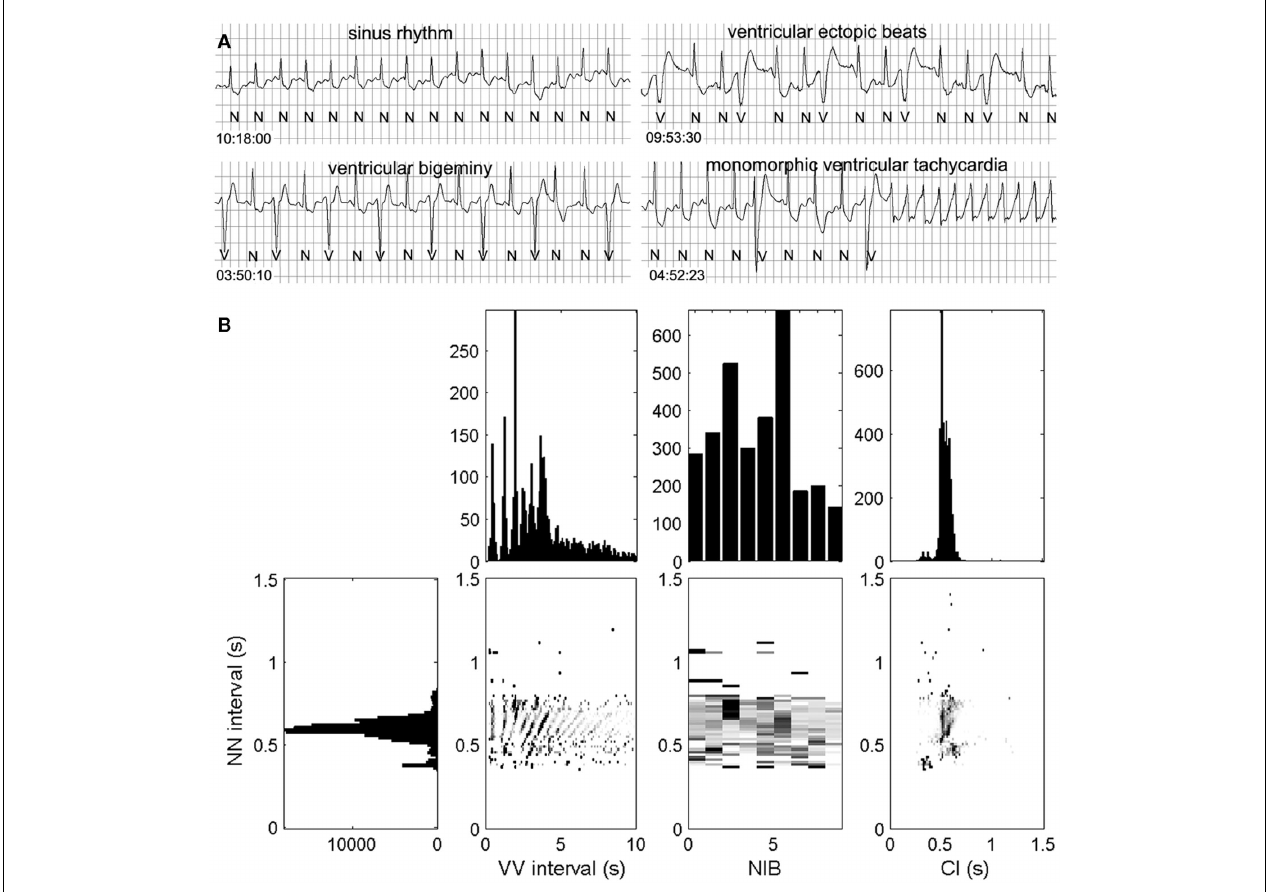
FIGURE 2 | Rhythm strip (A) and the heartprint (B) for an 80-year-old male patient with unknown clinical history. Heartprint shows that NN intervals were between 0.4 and 0.8s with a wide range of NIB values and coupling interval (CI) was highly variable. Case 48 from the PhysioNet Sudden Cardiac Death Data Base (Goldberger et al.,